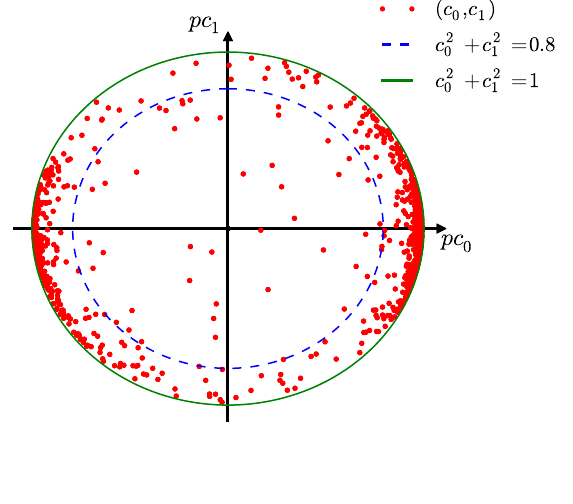
Figure 7 . Representation of each microsaccade candidate in the pc 0 - pc 1 -coordinate system. Each dot is given by ( c 0 , c 1 ) . The contribution of both of our model components is ex- plained in this coordinate system. We take binocular singu- larities as binocular microsaccades whose variability is de- scribed to more or equal than 80% by our model (red dots between inner blue dashed and outer green solid